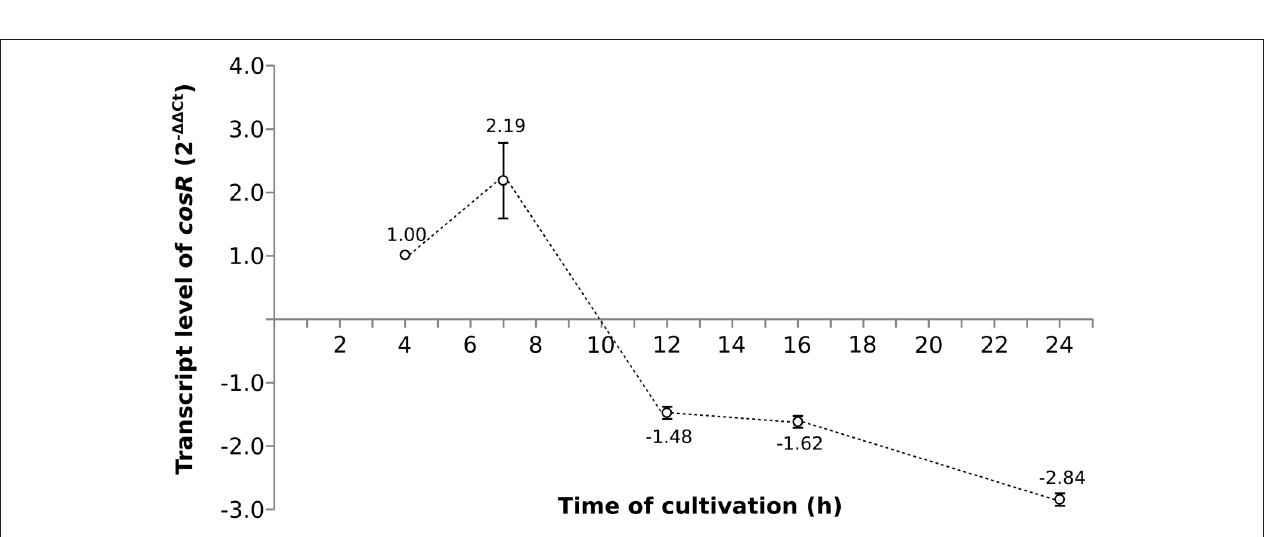
FIGURE 3 | The dynamics of cosR transcript level throughout the growth of C. jejuni normalized to the transcript level at 4